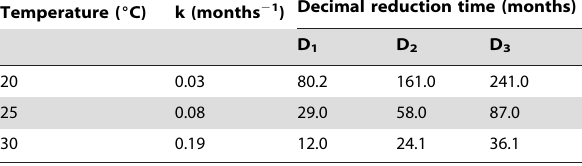
Table 4. Kinetic parameters of Bacilor H ( Lcr restituo H capsules).